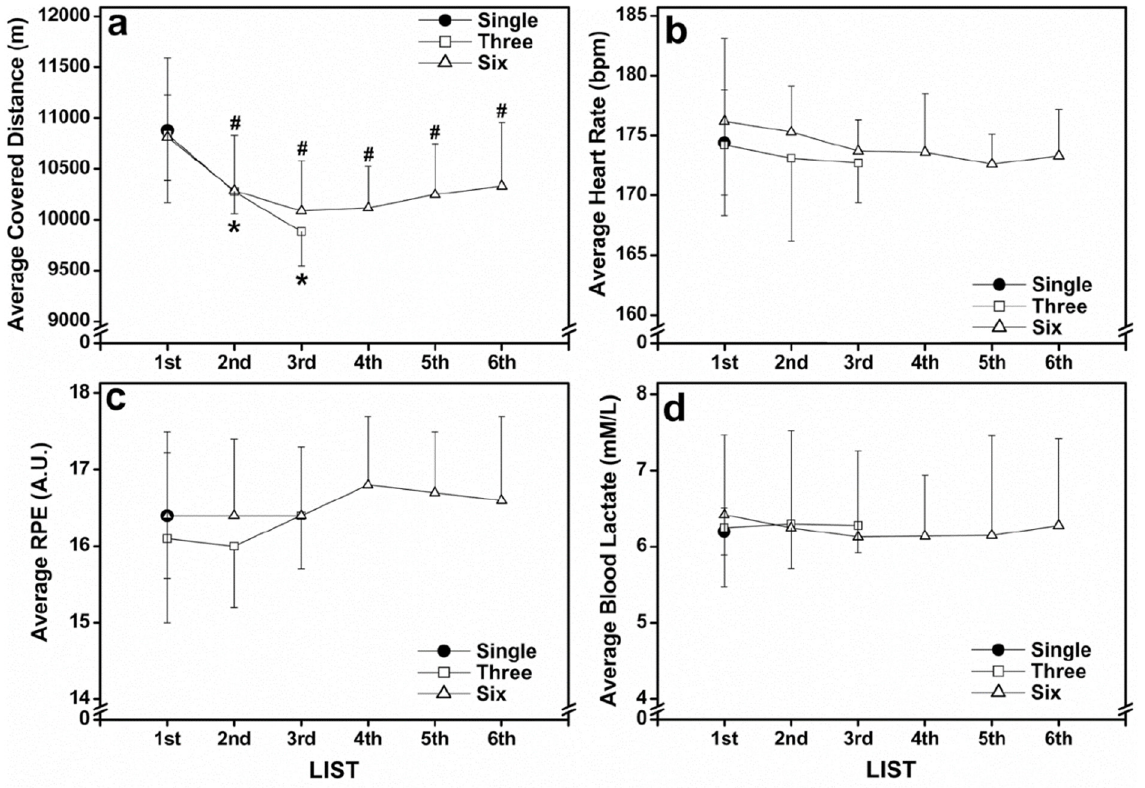
Figure 2. Average changes (mean ± SD) in the total distance covered ( a ), heart rate ( b ), ratings of perceived exertion (RPE, c ) , and blood lactate concentration (LA, d ) in the Loughborough Intermittent Shuttle Test (LIST) for one LIST (Single), three LISTs (Three) and six LISTs (Six) conditions. An asterisk (*) indicates a significant difference ( p < 0.05) between Single and Three conditions; a hash ( # ) indicates a significant difference ( p < 0.05) between Single and Six conditions.